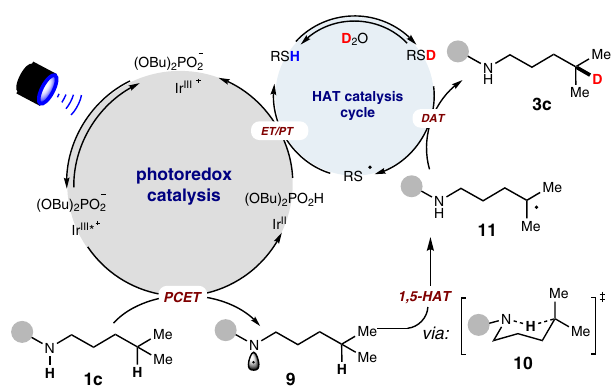
Fig. 5 Mechanism proposal. Proposed mechanism for this synergistic catalyzed remote C-H bond